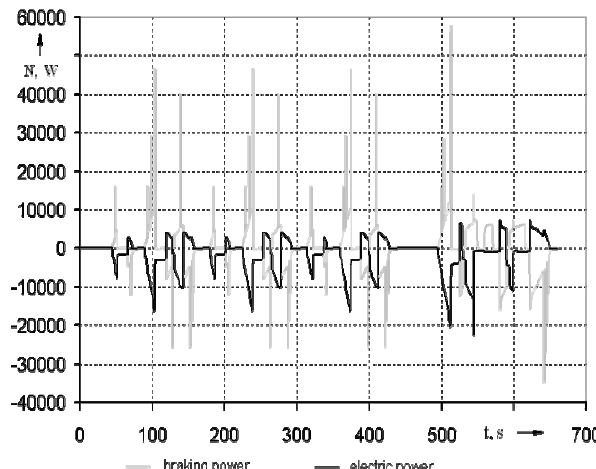
Table 1. Characteristics of Japanese and New European driving cycles